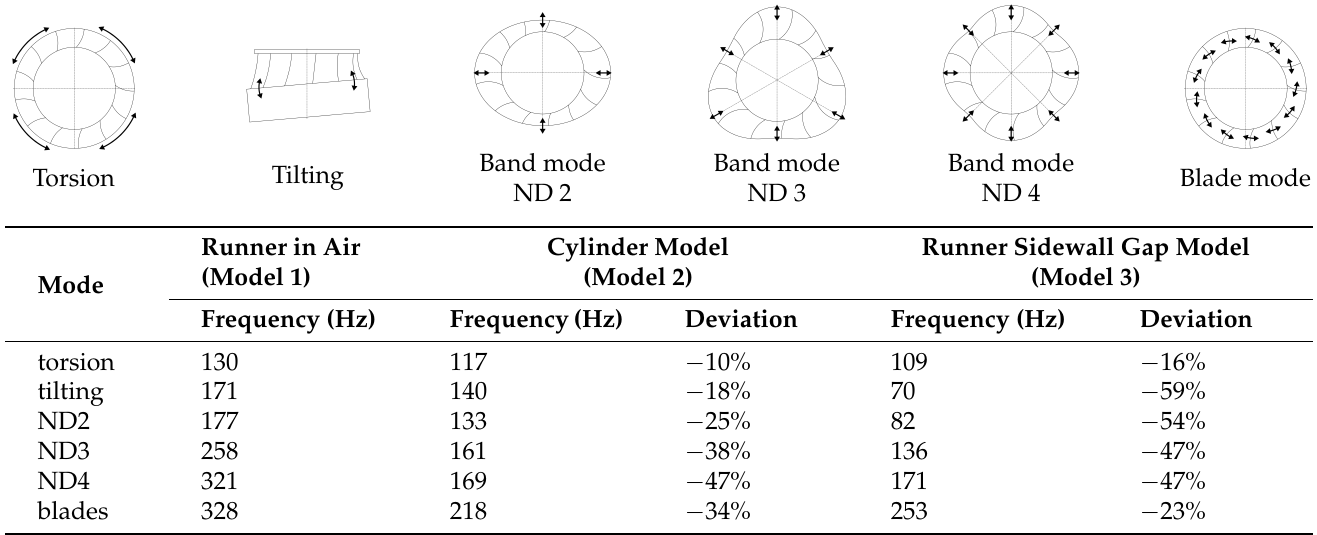
Table 8. Eigenfrequencies of the runner and their modes.